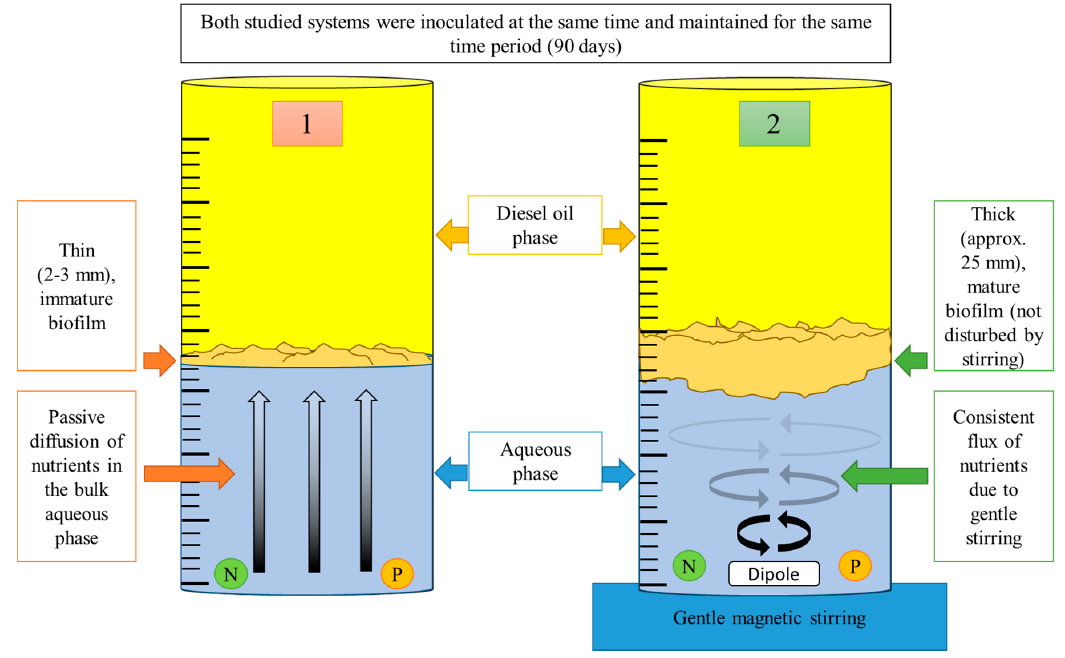
Figure 2. Experimental set-up of the experiment used to illustrate the influence of nutrient limitation on the development of bacterial biofilms at the diesel oil/water interface. on the development of bacterial biofilms at the diesel oil / water